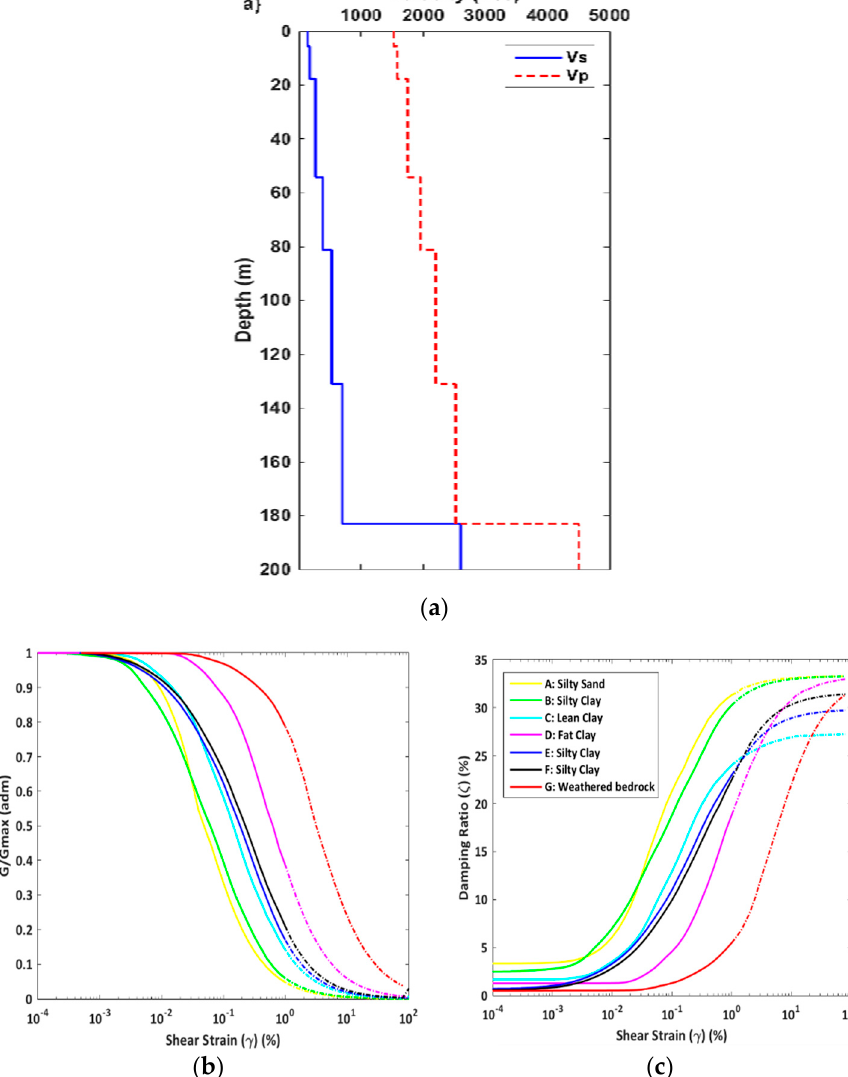
Figure 2. ( a ) One-dimensional (1D) shear wave, Vs, and compressive wave, Vp, velocity profiles between TST0 and TST196 stations, located at the middle of the Euroseistest basin, at surface and 196 m depth, respectively. ( b ) Euroseistest shear modulus and ( c ) damping ratio degradation curves [27]. Table 1. Material properties of the Euroseistest soil profile used on this study to perform the different site response calculations.